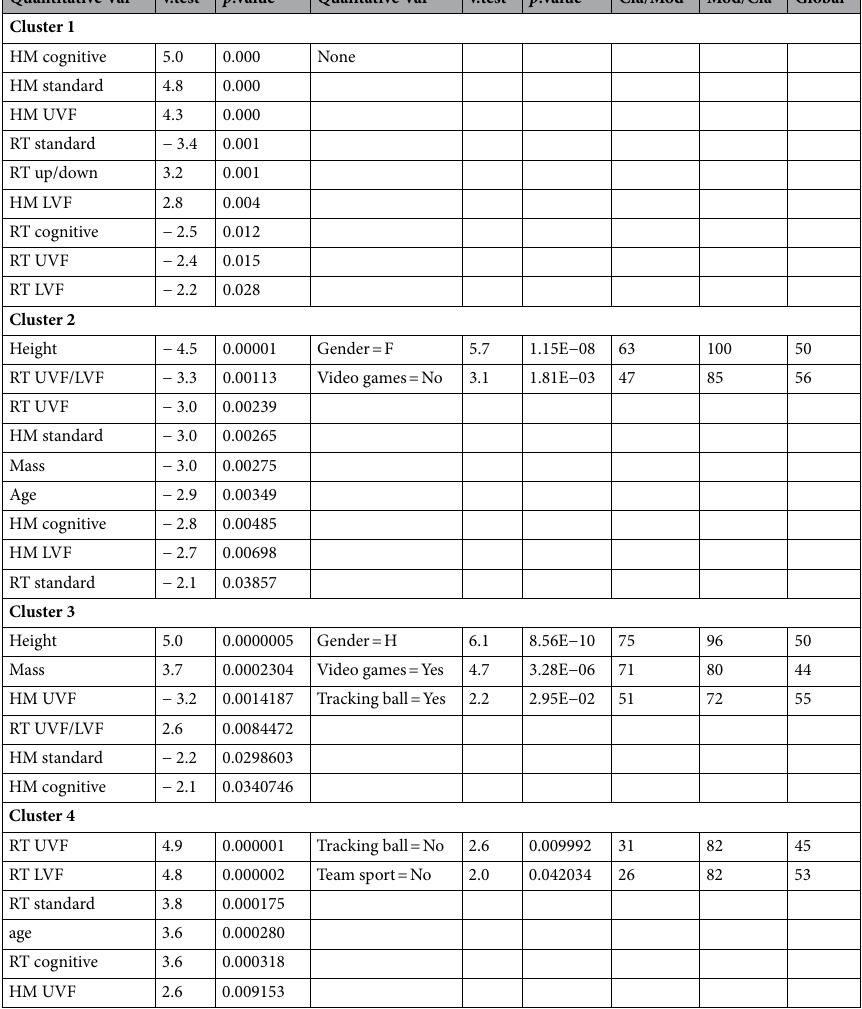
Table 3. Cluster description by the qualitative and quantitative variables. The column ‘v.test’ represents the statistical value used to determine the significance of the variables describing the group (a positive value indicates an over-representation of the modality under consideration; a negative value represents an under- representation). The column ‘Cla/Mod’ indicates what percentage of all individuals with this modality are in this cluster. For example, almost 63% of the females are in cluster 2. The column ‘Mod/Cla’ indicates what percentage of all individuals in the cluster have this modality. For example, 100% of subjects classified in Cluster 1 are females. The column ‘Global’ indicates the percentage of subjects out of the total population with this